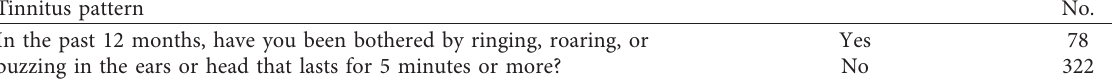
Table 1: Pattern of tinnitus among health science students in King Khalid University, Abha, Saudi Arabia, 2019. Tinnitus pattern No. % In the past 12 months, have you been bothered by ringing, roaring, or buzzing in the ears or head that lasts for 5 minutes or more? How long have you been bothered by this ringing, roaring, or buzzing in the ears or head? ( n � 78) ears/head? Are you bothered by ringing, roaring, or buzzing in your ears or head only after listening to loud sounds or loud music? ( n �